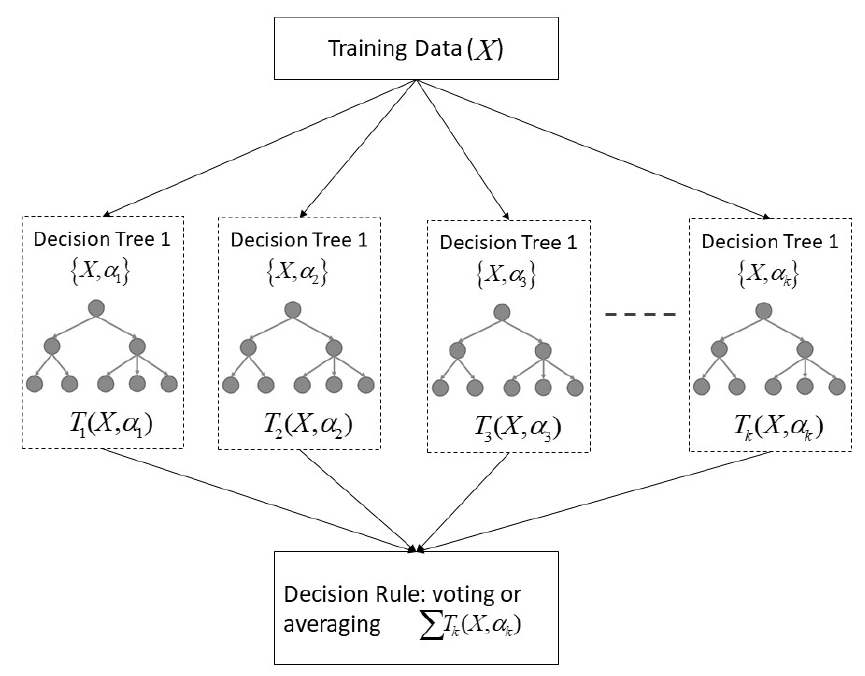
Figure 1. The structure of random forest